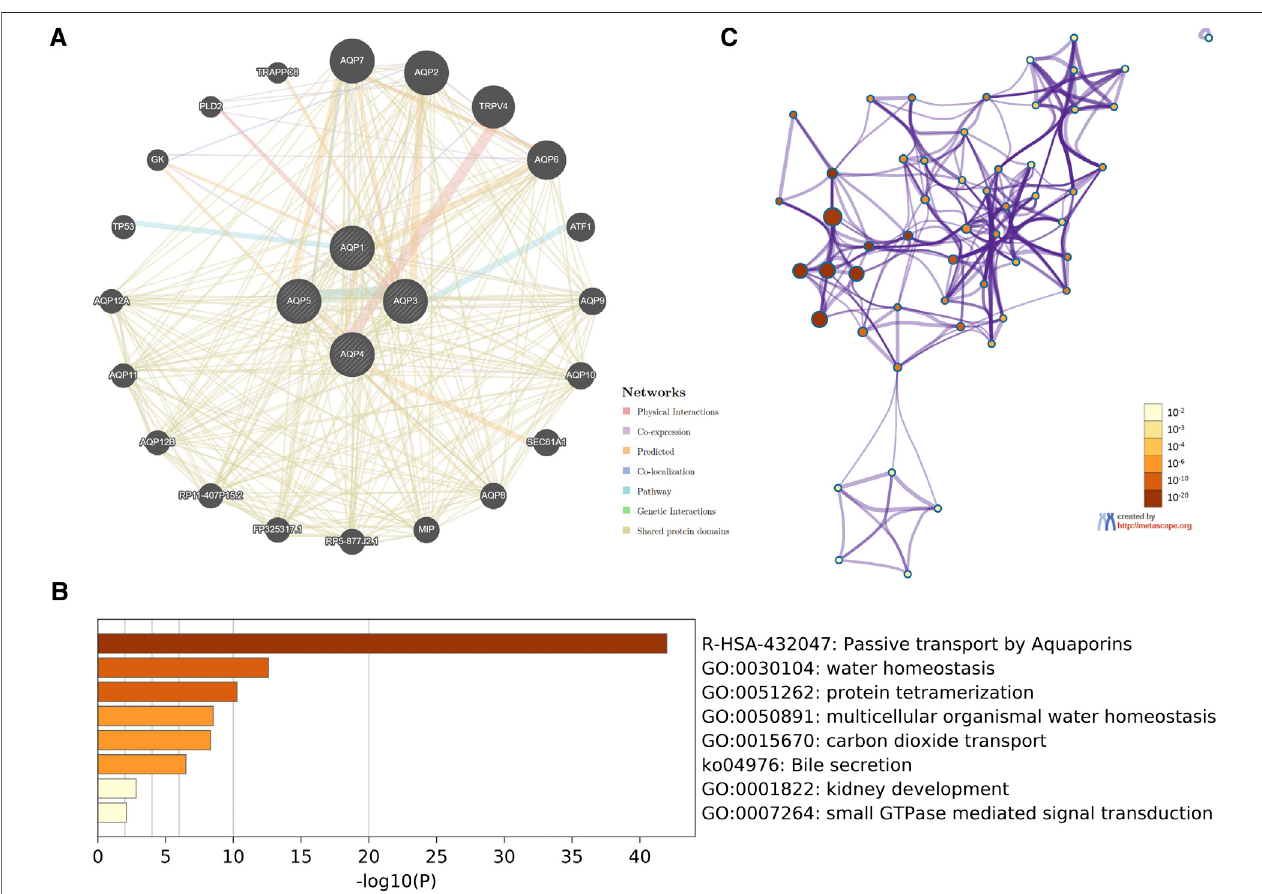
FIGURE5| Interaction networkand functional enrichmentanalysisoffourAQPfamily genesinLUADpatients. (A) Co-expressionnetworkofAQPgenesbased on GeneMANIA. (B) Metascape analysis of top eight functional categories enriched in the AQPs. (C) Associations between these top eight clusters enrichment terms displayed as a network analyzed by